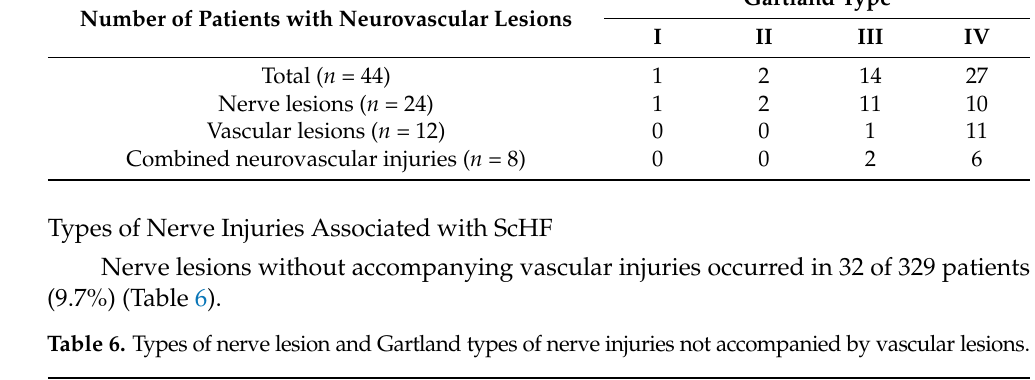
Table 6. Types of nerve lesion and Gartland types of nerve injuries not accompanied by vascular lesions. Type of Predominant Nerve